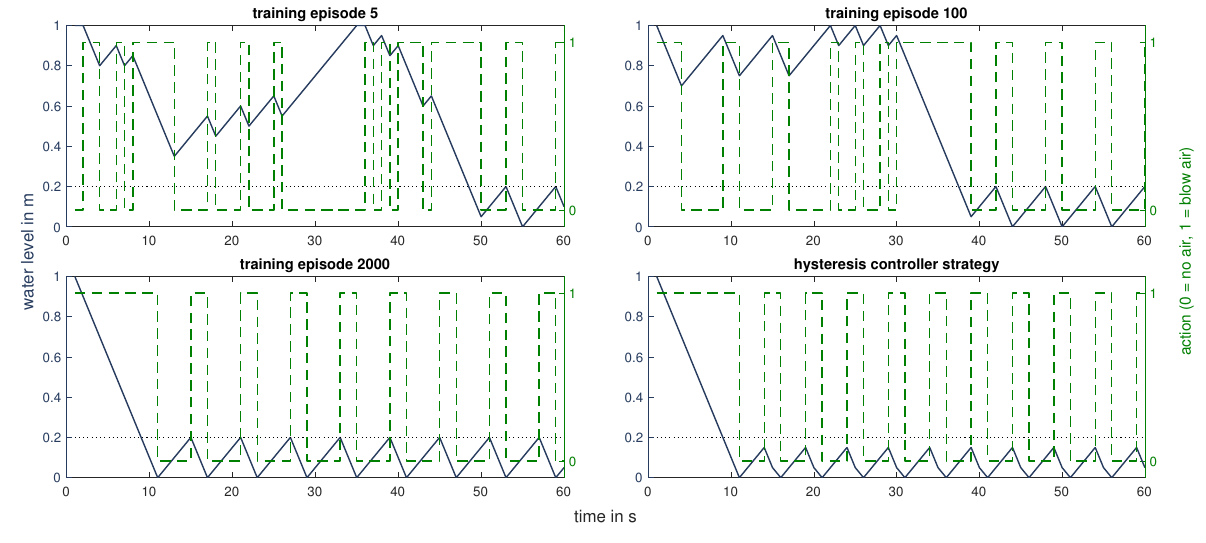
Figure 4. Control strategies for the blow-out process of different training stages of the RL agent as well as the strategy of the baseline controller. Water level in draft tube in m and control action over the first 60 s of an episode. The dotted horizontal line indicates the water level under which the runner is considered blown